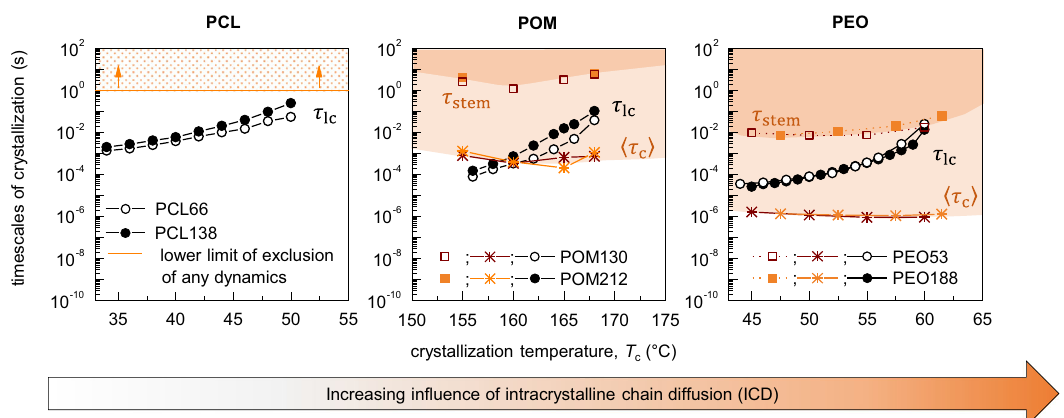
Fig. 2 Comparison of the timescales underlying intracrystalline chain diffusion and crystal growth for PCL, POM, and PEO. τ lc corresponds to the time during which the crystal grows by one molecular layer according to Eq. (1). 〈 τ c 〉 is the average residence time between two helical jumps calculated with Eq. (2) and the values given in the Supplementary Table 3. τ stem denotes the time during which a chain in the crystal diffuses over a distance equal to the lamellar thickness d c , estimated by Eq. (3). 〈 τ c 〉 can be considered as a lower and τ stem as an upper limit of the timescale of crystal reorganization enabled by the α c -relaxation. For PCL the solid line shows the NMR detection limit for 〈 τ c 〉 due to a possible, undetectably slow α c -relaxation and thus ICD 37 . Figure partially adapted from https://pubs.acs.org/doi/10.1021/acs.macromol.8b01102, further permission related to the material excerpted should be directed to the